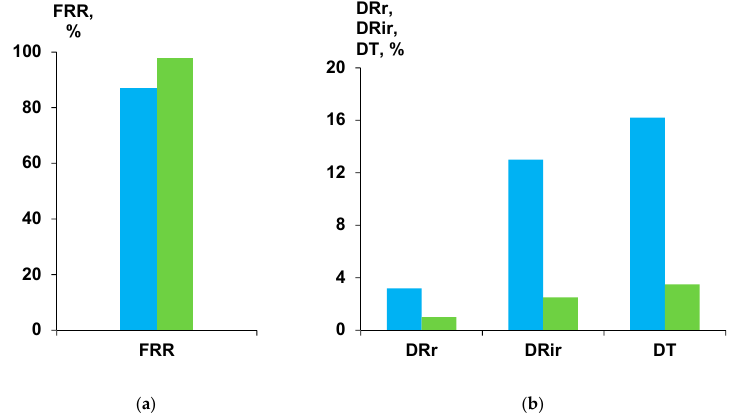
Figure 12. Fouling parameters ( a ) FRR and ( b ) DRr, DRir, DT in the process of 0.001% humic acid solution ultrafiltration using A25 (blue) and A-0.3-25 (green) membranes. Table 4. Characteristics of feed and permeate upon ultrafiltration of humic acid solution.